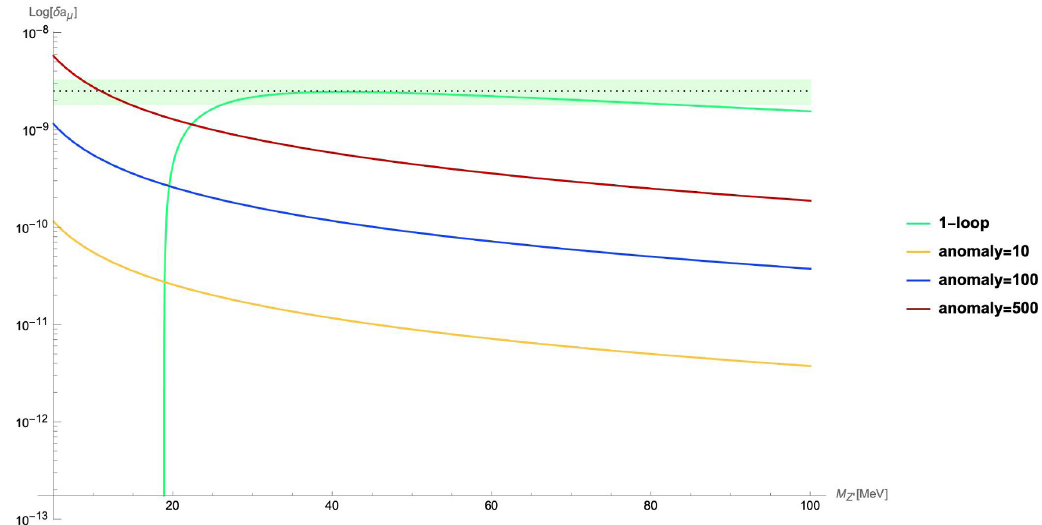
Figure 3 . In this plot, we present the one-loop contribution of an anomalous Z 0 to the g − 2 of the muon for masses m